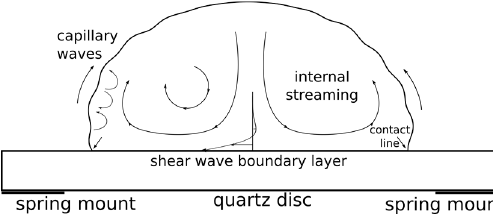
Figure 2. Acoustic streaming is induced in the sessile droplet of sample liquid at sufficiently high oscillation amplitudes. This way, particulate matter is resuspended and the settling can be observed by tracking the shift in the resonance frequencies of both the quartz plate and the electrodynamic